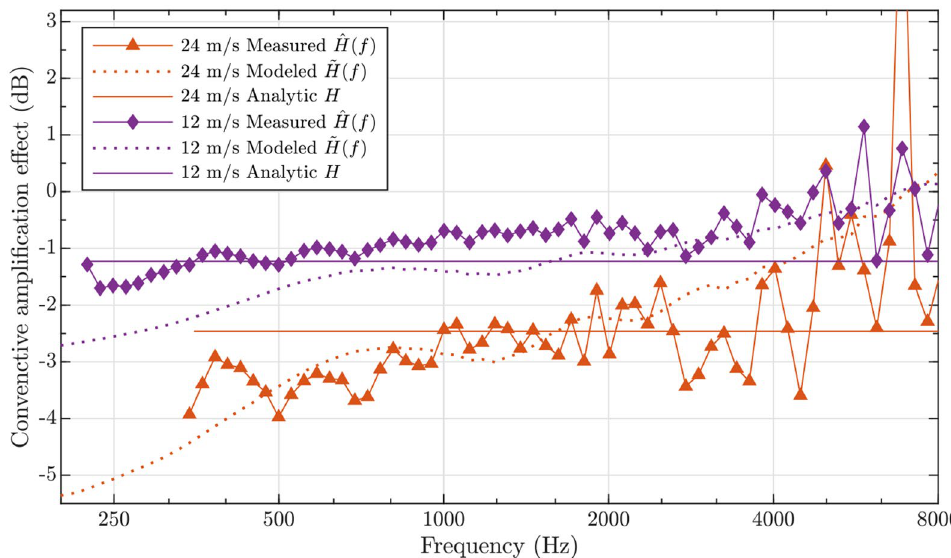
Figure 2. The change of sound pressure level in the vicinity of ear canals in upwind shouting vs. downwind shouting. The convective effect is estimated using measurements, multiphysics simulations, and with an analytic solution (Eq. 1) valid for point sources in free field. The effect is shown in decibel scale computed by taking 20log ( · ) on estimated or measured value. Values lower than zero imply lower sound pressure level at ears in the case of upwind shouting than in the case of downwind shouting. A cylindrical object was placed in static air flow, with sound source either facing upwind or